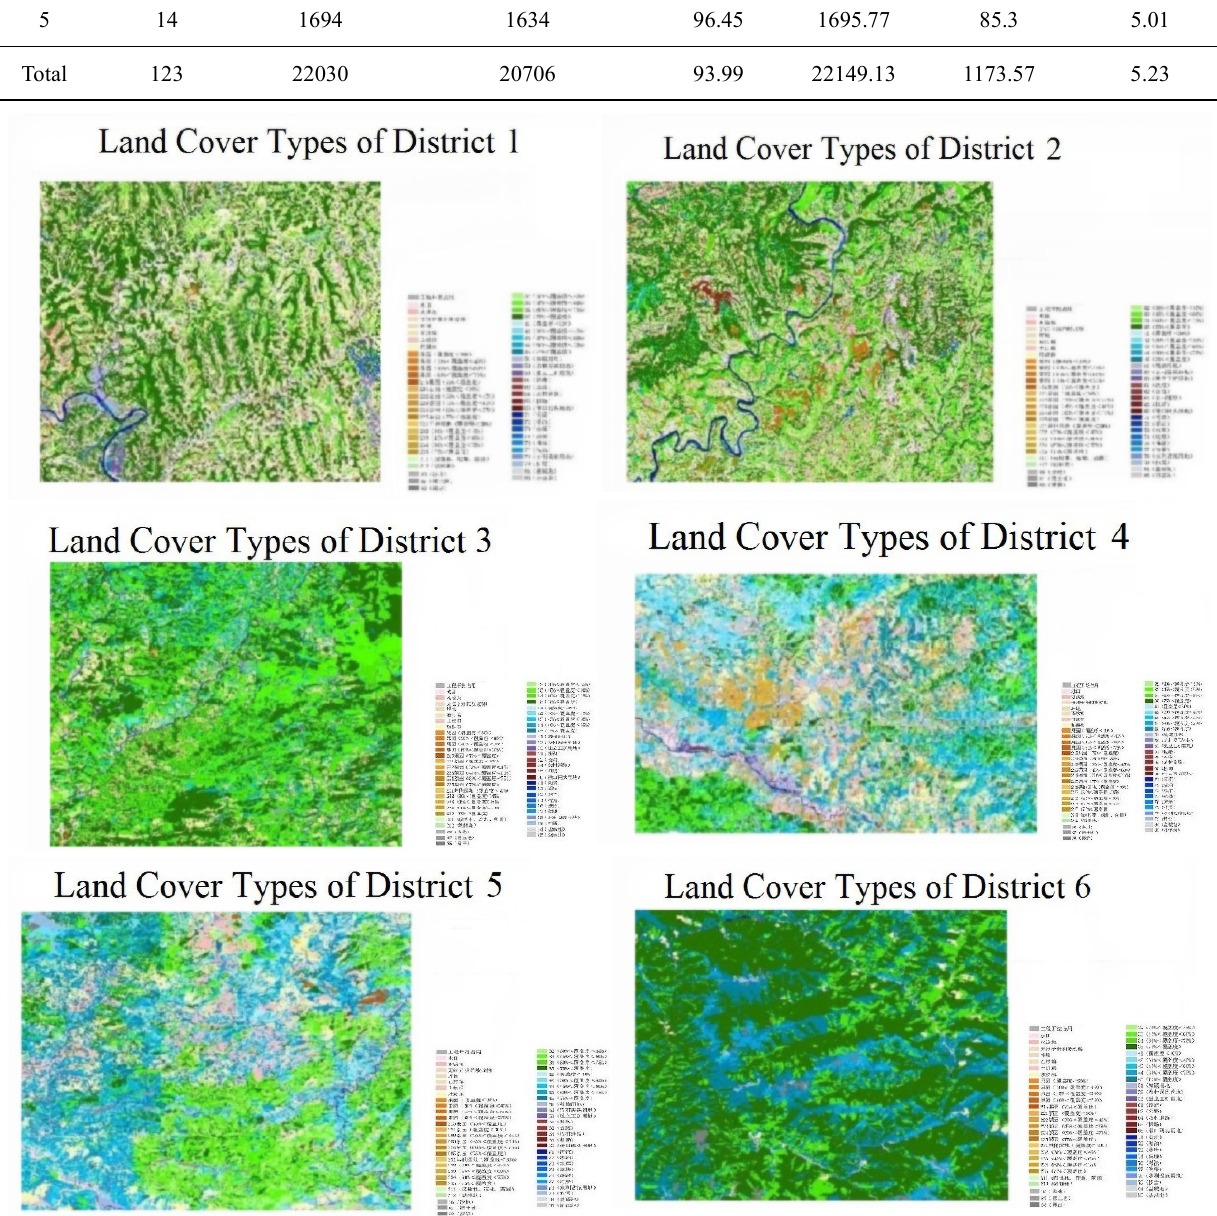
Figure 2 The Interpreted Results of Land Cover Types of Project